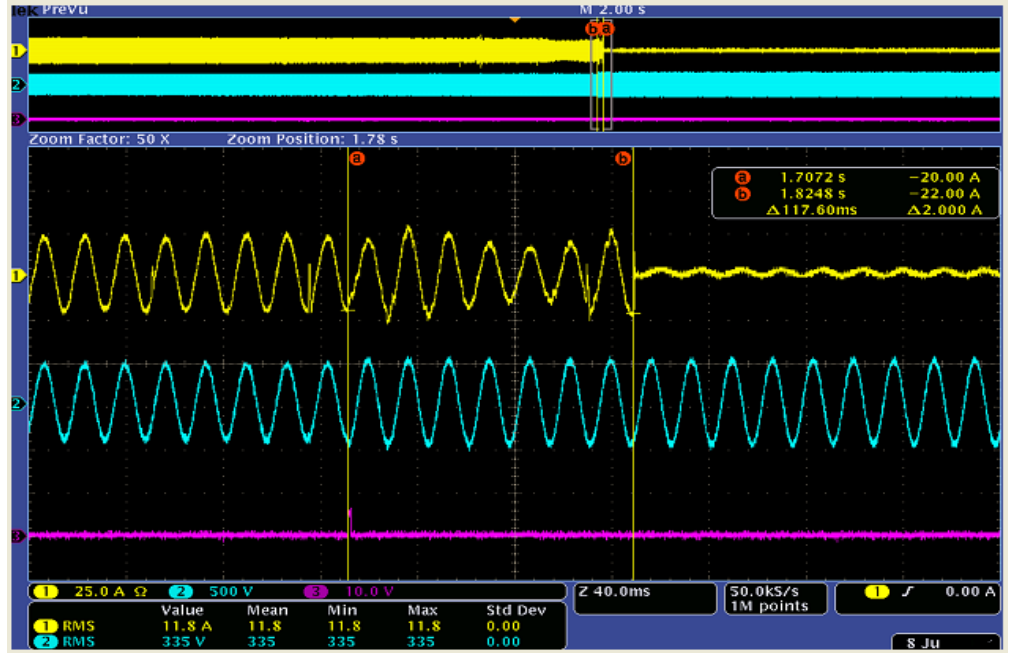
Figure 22. Microgrid system disconnection during under frequency fault in Off-grid mode of operation.